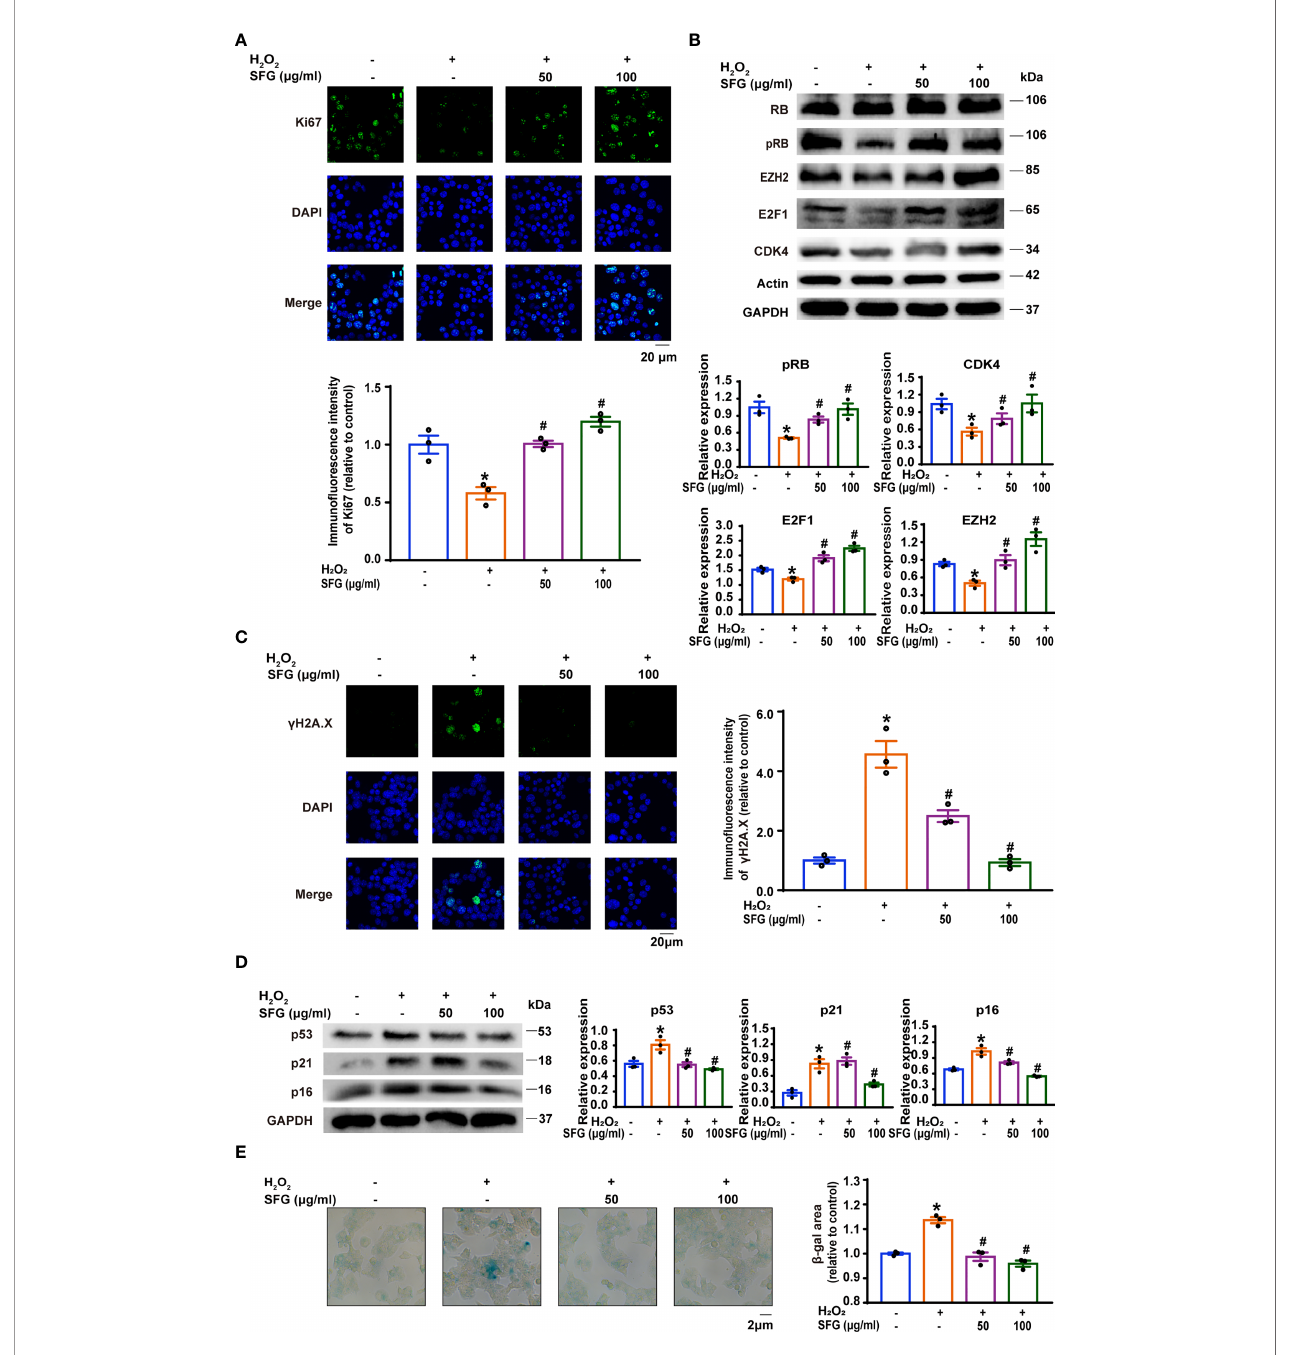
FIGURE 3 | SFG promoted the inhibited proliferation of H 2 O 2 -treated MIN6 cells and ameliorated their senescence. (A) Immuno fl uorescence staining of Ki-67 expression in MIN6 cells (n=3). Quantitative analysis of Ki-67 expression was shown. *P < 0.05 versus control; # P < 0.05 versus H 2 O 2 -only group. (B) Western blot analysis of the expression of the cell cycle regulator proteins RB, pRB, EZH2, E2F1, and CDK4 in MIN6 cells (n=3). GAPDH was used as a loading control for pRB, EZH2 and E2F1, actin was used as a loading control for CDK4. Densitometric analysis of the Western blot bands were shown. *P < 0.05 versus control; # P < 0.05 versus H 2 O 2 -only group. (C) Immuno fl uorescence staining of g H2A.X in MIN6 cells (n=3). Quantitative analysis of g H2A.X expression was shown. *P < 0.05 versus control; #P < 0.05 versus H2O2-only group. (D) Western blot analysis of the expression of the senescence-associated proteins p16, p21, and p53 in MIN6 cells (n=3). GAPDH was used as a loading control. Densitometric analysis of the Western blot bands were shown. *P < 0.05 versus control; # P < 0.05 versus H 2 O 2 -only group. (E) SA- b -gal staining in MIN6 cells (n=3). b -gal staining area analysis was shown. *P < 0.05 versus control; # P < 0.05 versus H 2 O 2 -only